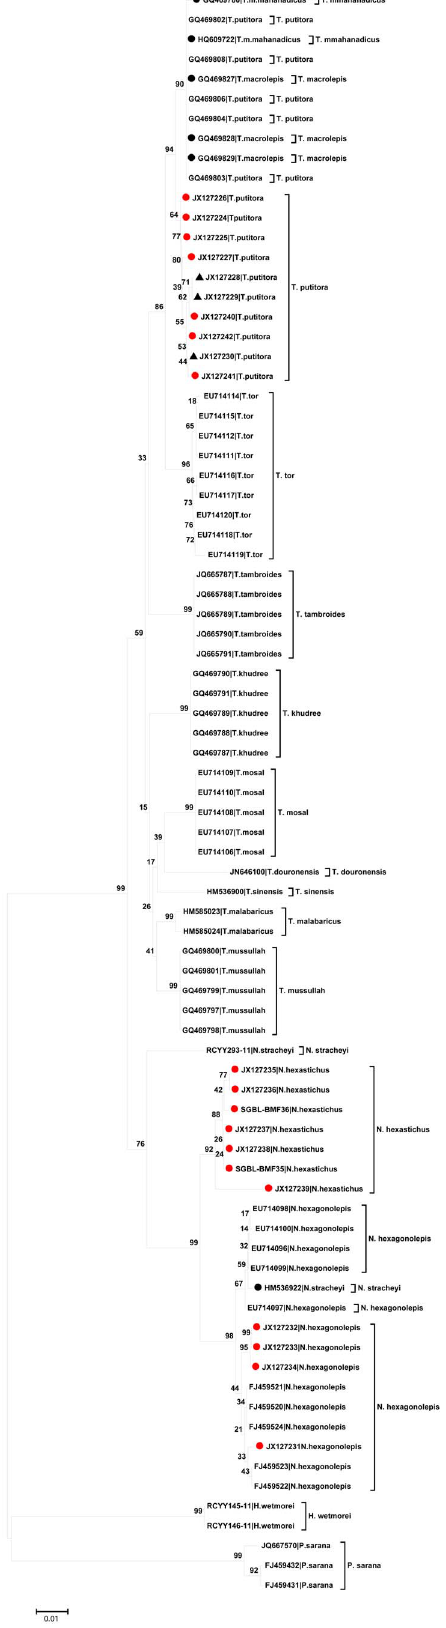
Figure 3. Neighbor Joining (NJ) tree developed using K2P distance among 76 COI sequences of mahseer. In most cases the studied samples (marked as red dots) showed cohesive clustering with their conspecific database sequences. The samples morphologically identified as Tor progeneius (accession numbers JX127229, JX127230 and JX127228) clustered conspecific with developed sequences as well as database sequences of T. putitora. All samples of N. hexastichus clustered cohesive as the same species and distinct from N. hexagonolepis sequences. Few database sequences of 3 species revealed aberrant clustering { Neolissochilus stracheyi (accession number N HM536922), Tor mosal mahanadicus (accession numbers HQ609722, The GQ469780), Tor macrolepis (accession numbers GQ469827-29)}. N numbers at the nodes are bootstrap values based on 1000 replications. N The specimens’ GenBank accession number and species name are Red dots and black triangles correspond to the shown for each taxon. sequences developed in this study. Black triangles also correspond to the sequences of samples, although morphologically identified as Tor progeneius but were found conspecific with Tor putitora based on COI sequence data analysis. Black dots correspond to the cases of abnormal